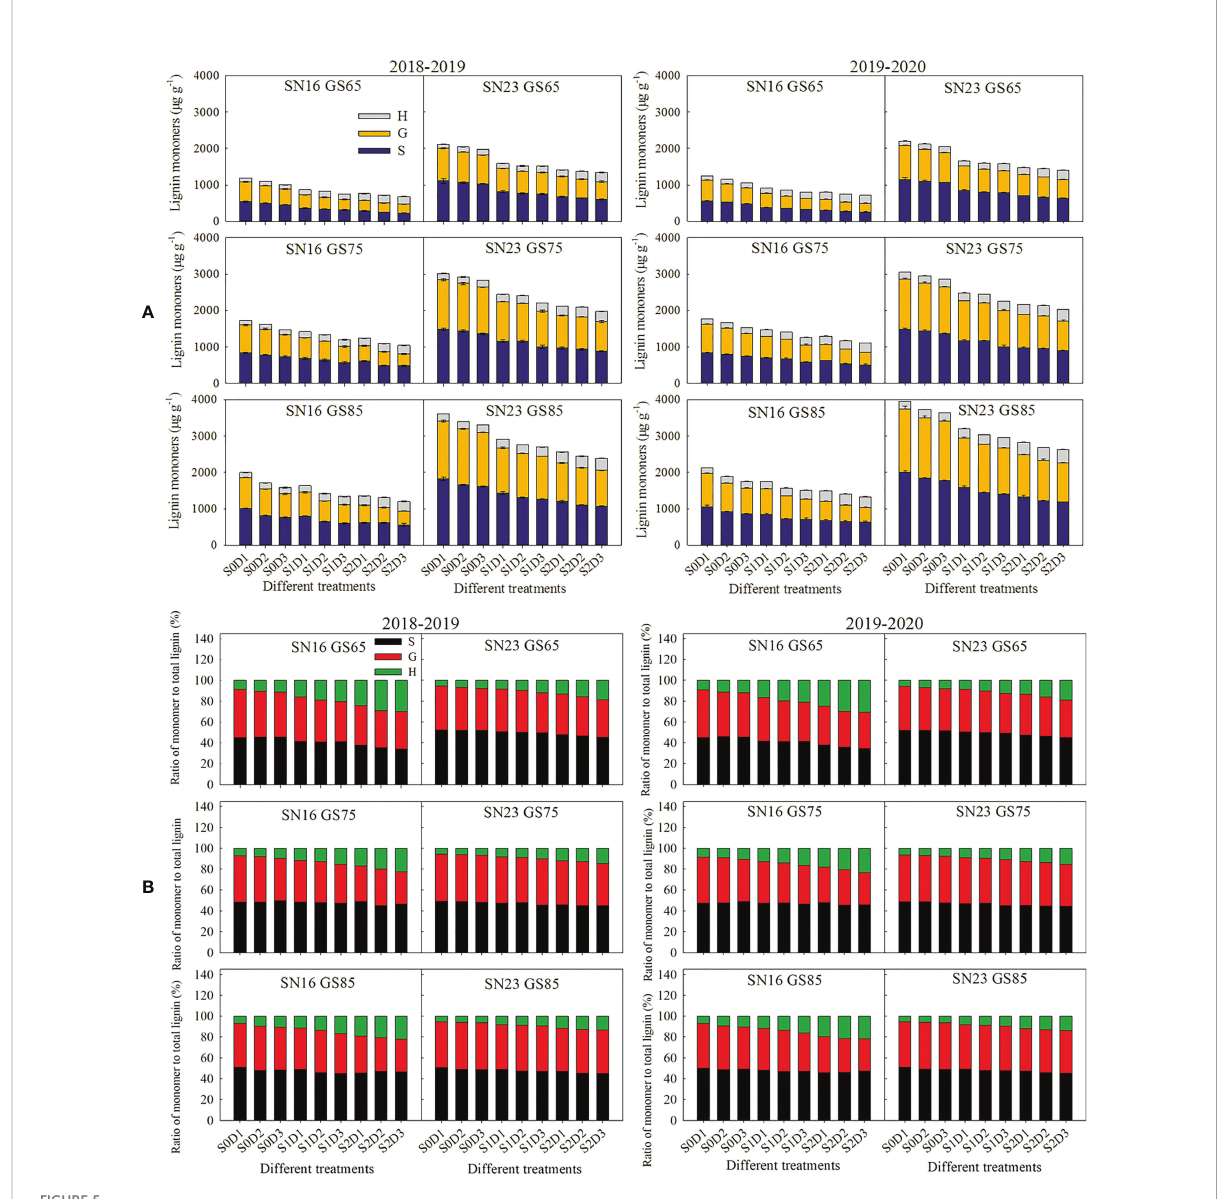
FIGURE 5 Effects of shading on the lignin monomers content (A) and the proportion of lignin monomers (B) in wheat stems under different planting densities. Error bars represent the standard deviation of the mean (n =